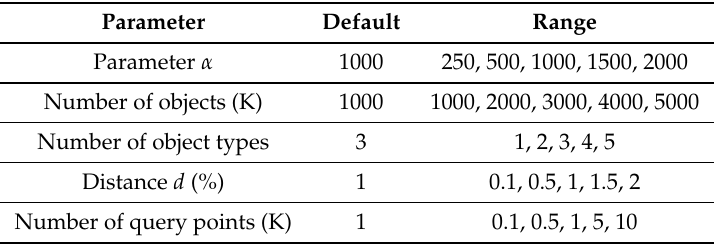
Table 1. System parameters.